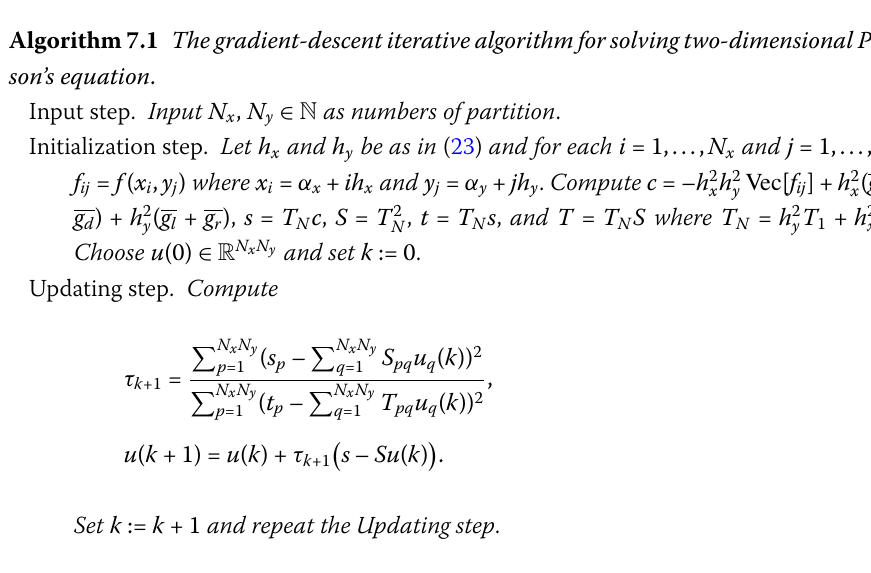
Algorithm 7.1 The gradient-descent iterative algorithm for solving two-dimensional Pois- son’s equation